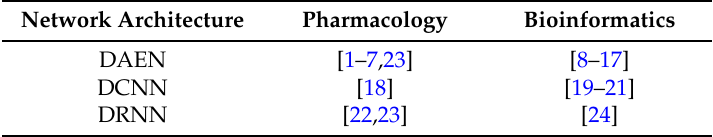
Table 2. Applications of different Deep Neural Networks (DNNs)